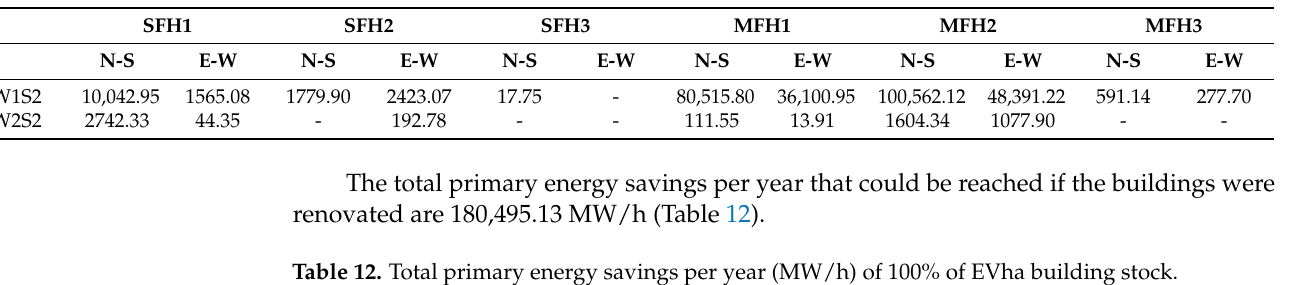
Table 11. Primary energy consumption per year (MW/h) in the current status of the building stock.